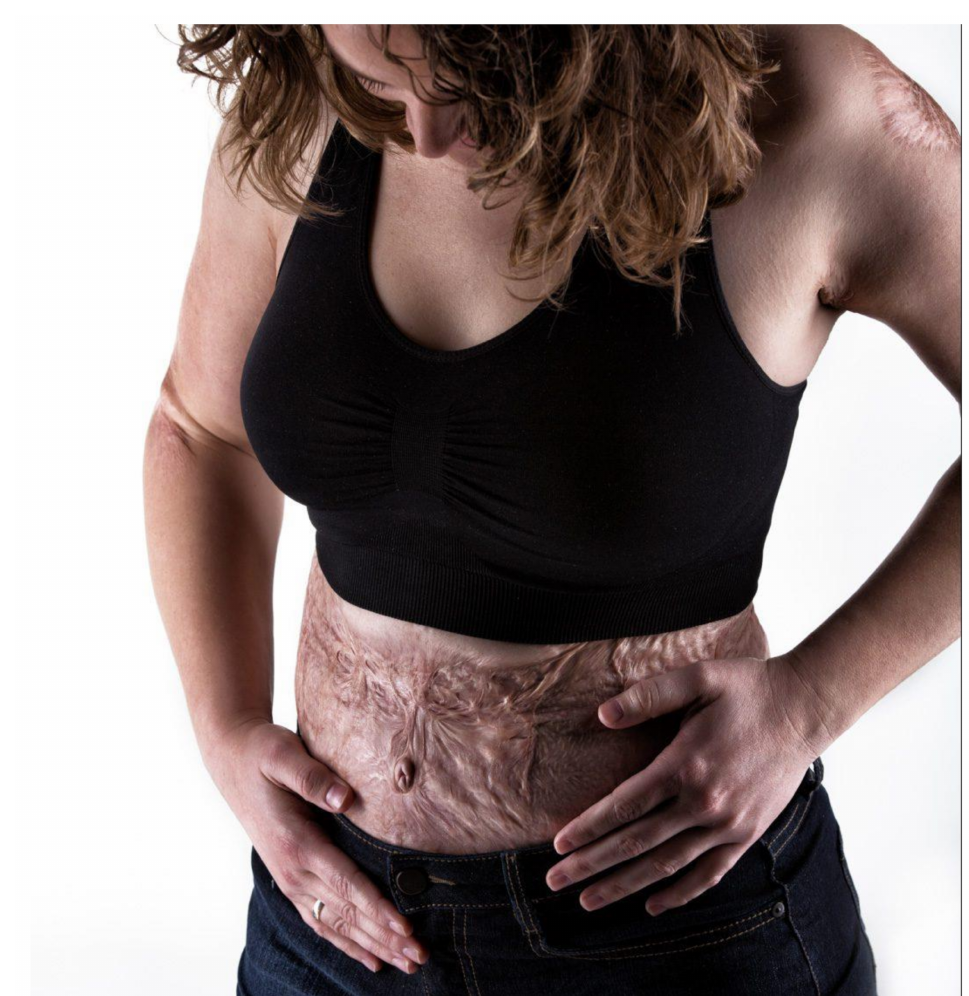
Figure A1. Photo by: Jan van Beijnhem, Foto Studio XL. Written permission from patient and